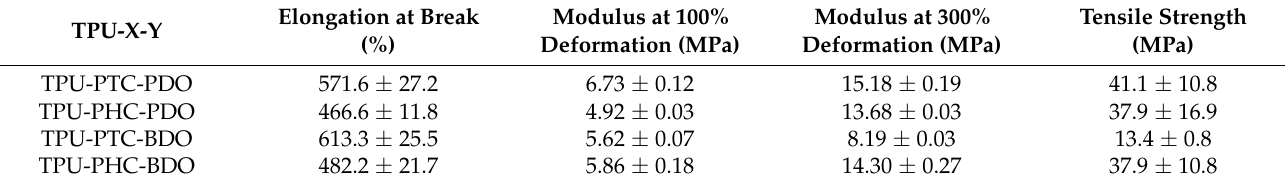
Table 6. Mechanical properties of the TPU